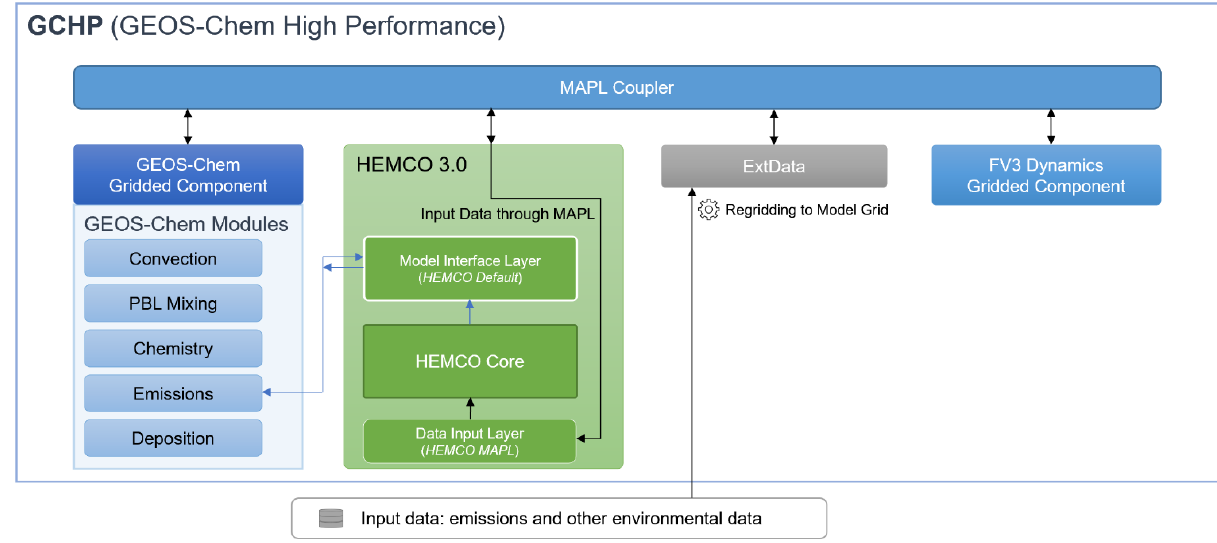
Figure 5. HEMCO 3.0 implementation in the GEOS-Chem High-Performance model (GCHP). GCHP operates under the MAPL coupling framework in an MPI parallel environment. The ExtData component reads all data into MAPL, re-gridding them to the model grid, and the input data are retrieved by the HEMCO MAPL implementation of the Data Input Layer. After emissions are processed by the HEMCO Core, they are exported to GEOS-Chem through the HEMCO default Model Interface